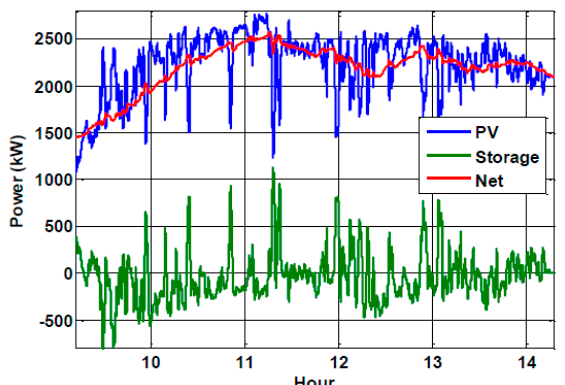
Figure 16. Example of solar PV output / ramp rate smoothing using battery energy storage on a cloudy day between 9:00–15:00 in California [57]. Blue line shows the fluctuating output of a PV system. Red line shows desired output of a PV system against its variability. The green line shows charging and discharging of the storage for smoothing PV output.